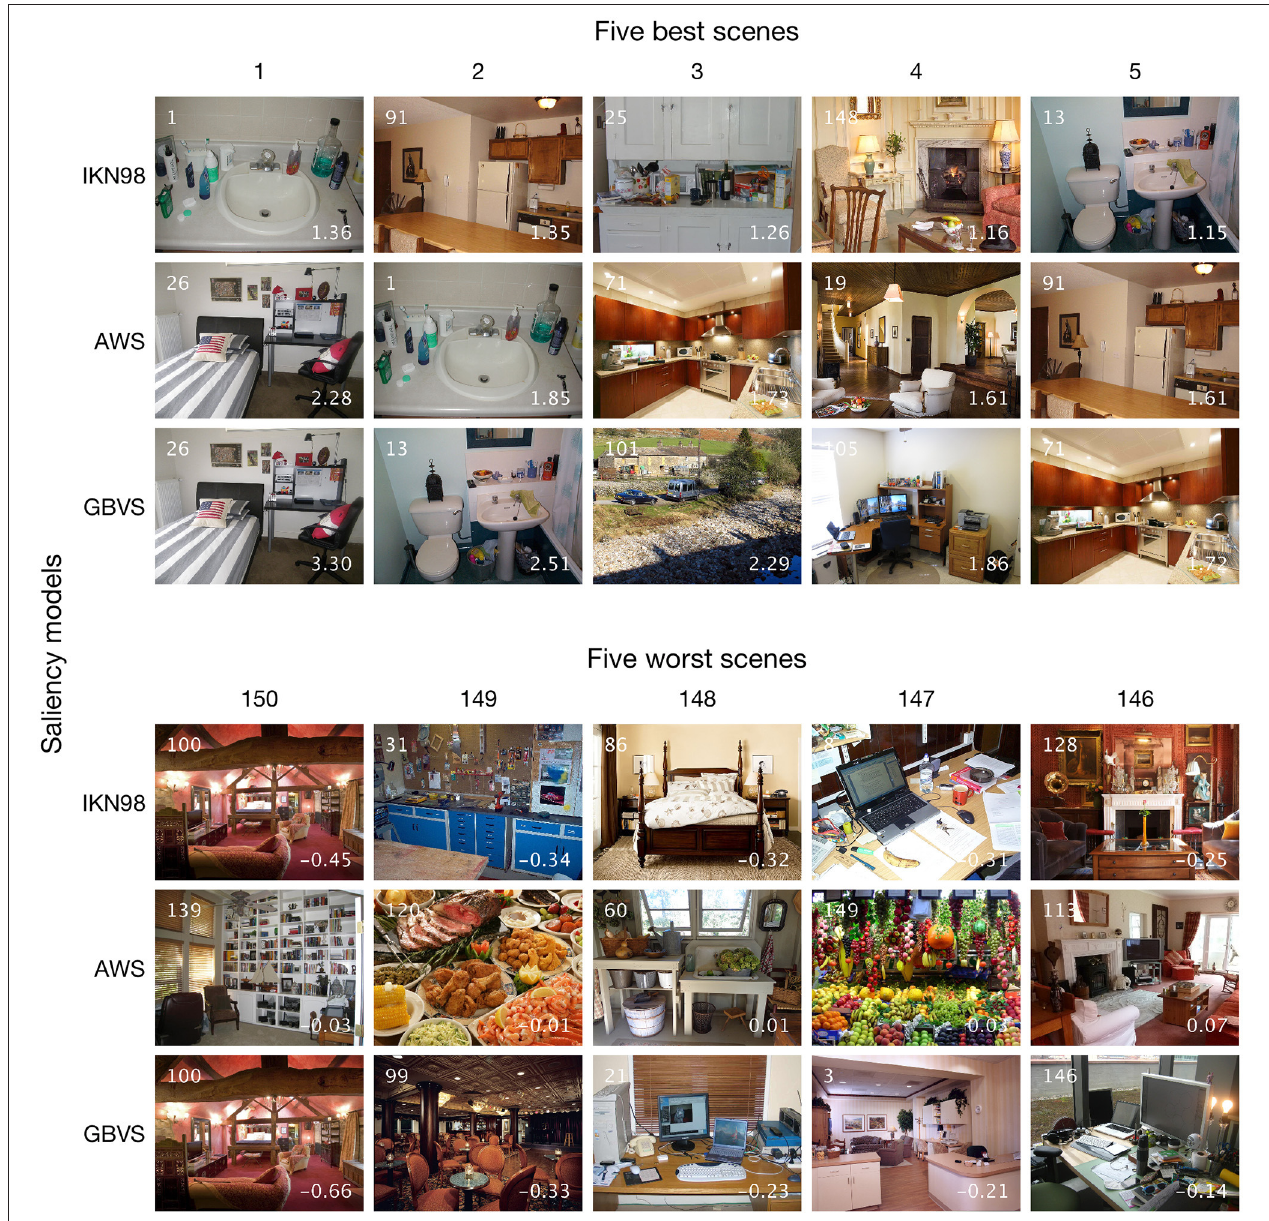
FIGURE 8 | Five best and five worst scenes based on by-item random slopes for image salience. The ranking (1–5 and 150–146) is based on the results from the three Central-Bias—Saliency GLMMs ( Table 3 ). Rows contrast the three tested saliency models. The three top rows show the five best scenes for a given saliency model; the five worst scenes are depicted in the bottom half of the figure. For a given thumbnail image, the white inset number at the top left is the scene ID. The numbers at the bottom right are the individual item coefficients, which are obtained as the sum of fixed-effect estimates and predictions for random effects. Note that there are common scenes for which the tested saliency models perform particularly